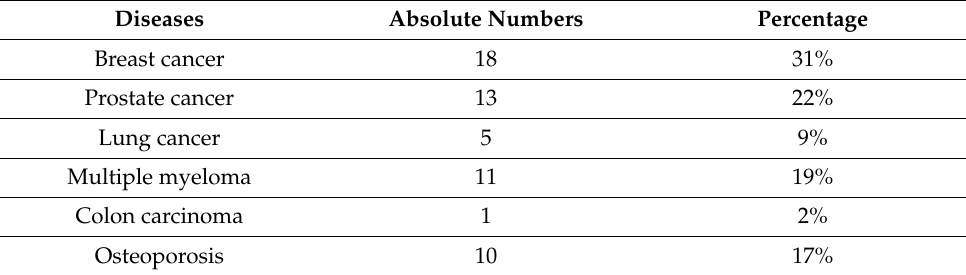
Table 2. Underlying diseases/indications for antiresorptive therapy ( n = 58).